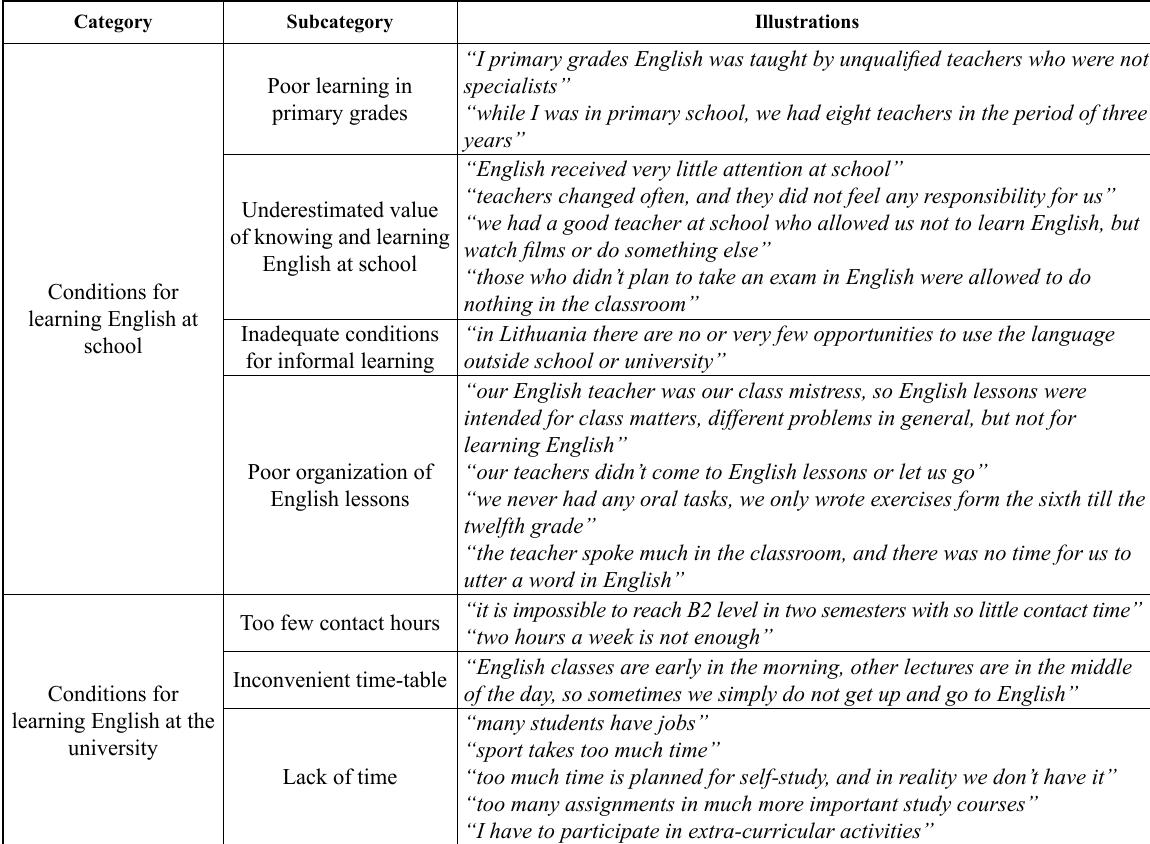
Table 2. External causes of underachievement in